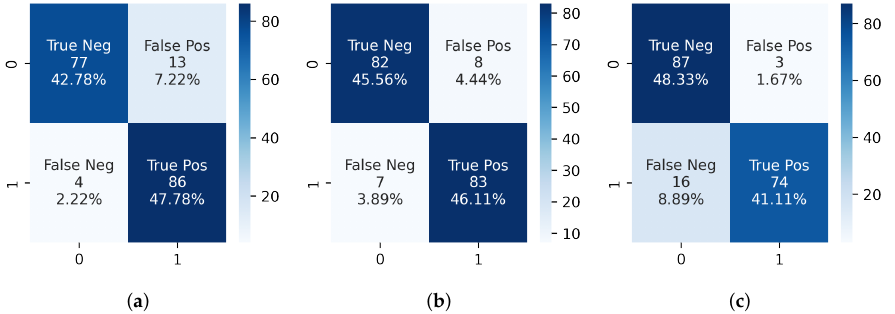
Figure 10. Confusion matrices obtained from IVCF prediction algorithm using ( a ) sig_count = 300, sequence = 5, ( b ) sig_count = 300, sequence = 7 and ( c ) sig_count = 300, sequence = 9. Here 1 represents IVCF scan and 0 represents normal